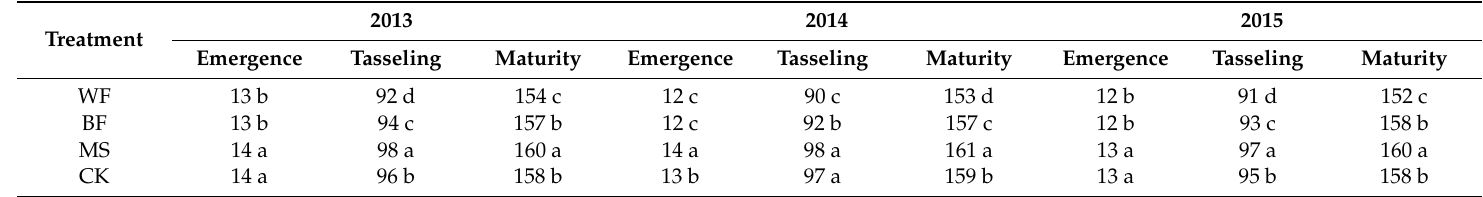
Table 4. Growth duration (days) of di ff erent growing stages of maize treated with di ff erent mulches (white transparent polyethylene film (WF), black polyethylene film (BF), and maize straw (MS)) and the non-mulched control (CK) in the 2013, 2014, and 2015 growing